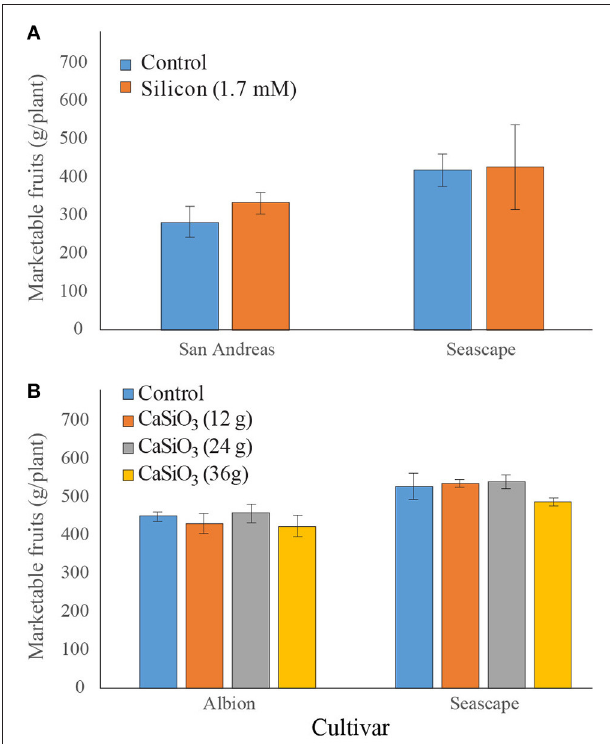
FIGURE 7 | Number of marketable fruits on strawberry plants treated or not twice a week with a 1.7 mM Si solution (A) in the field for summer 2015 or treated or not with different concentrations of wollastonite (B) in summer 2016. Each value represents the mean ± SE ( n = 3 in 2015; n = 6 in